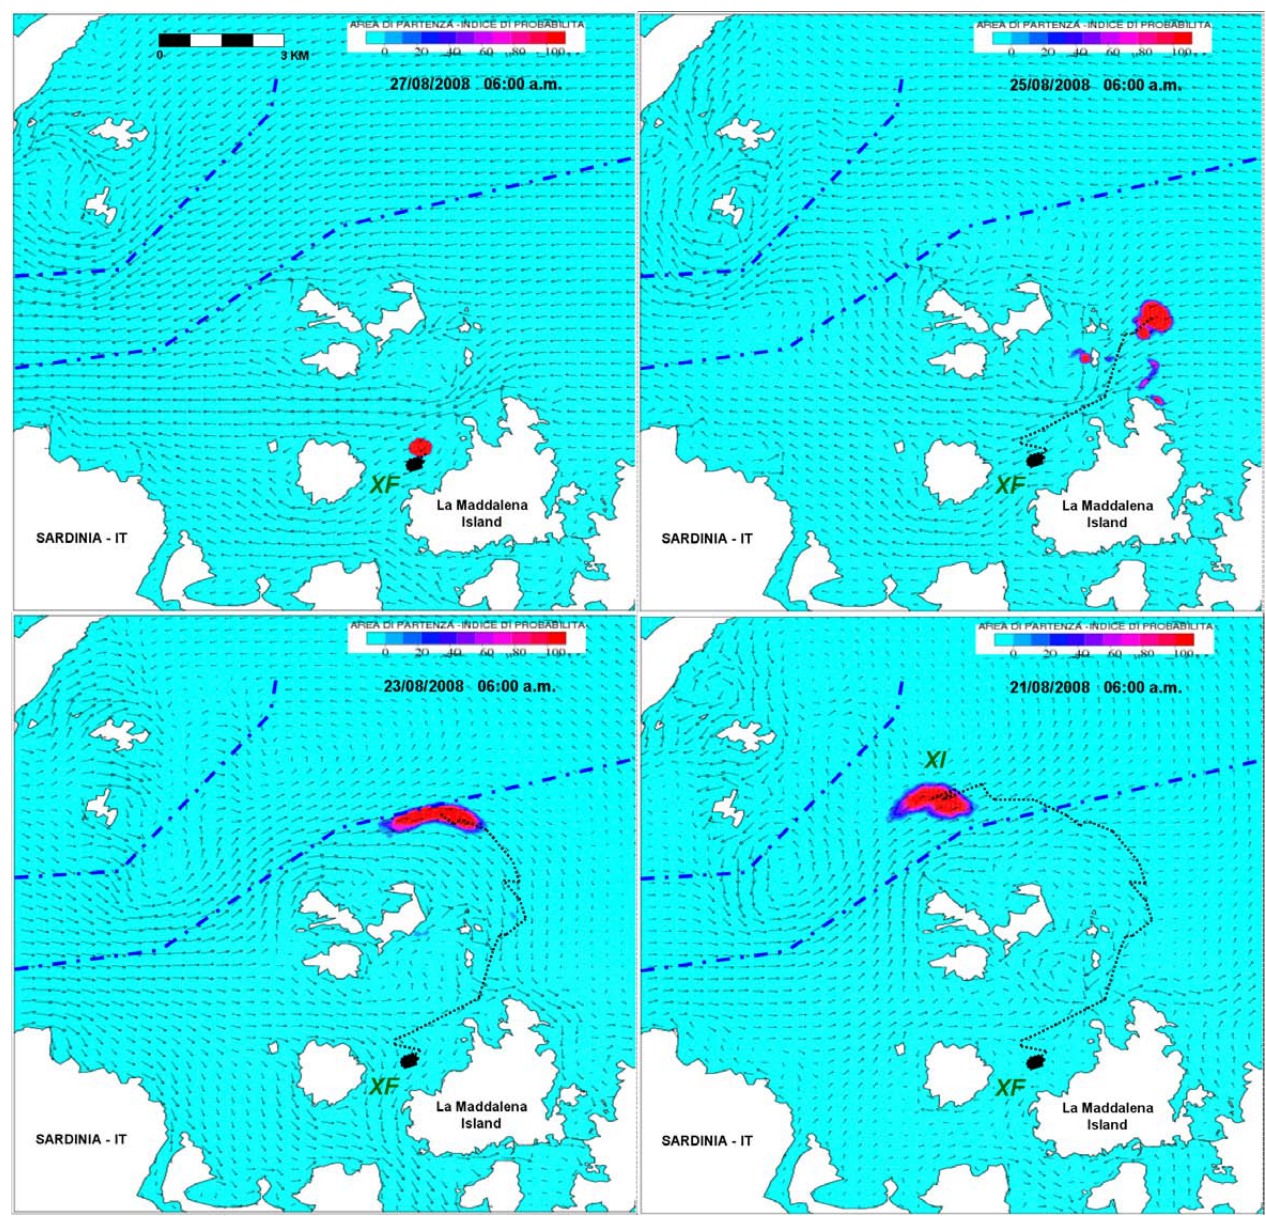
Fig. 4. Results of the backward investigation: XF and XI are the final and the most probable initial positions of the oil slick respectively at time TF (27 August 2008 at 06:00 a.m.) and at time TI, which corresponds to 6 days before TF (21 August 2008 at 06:00 a.m.). The areas between the blue dashed lines correspond to the maritime traffic route through the Strait of